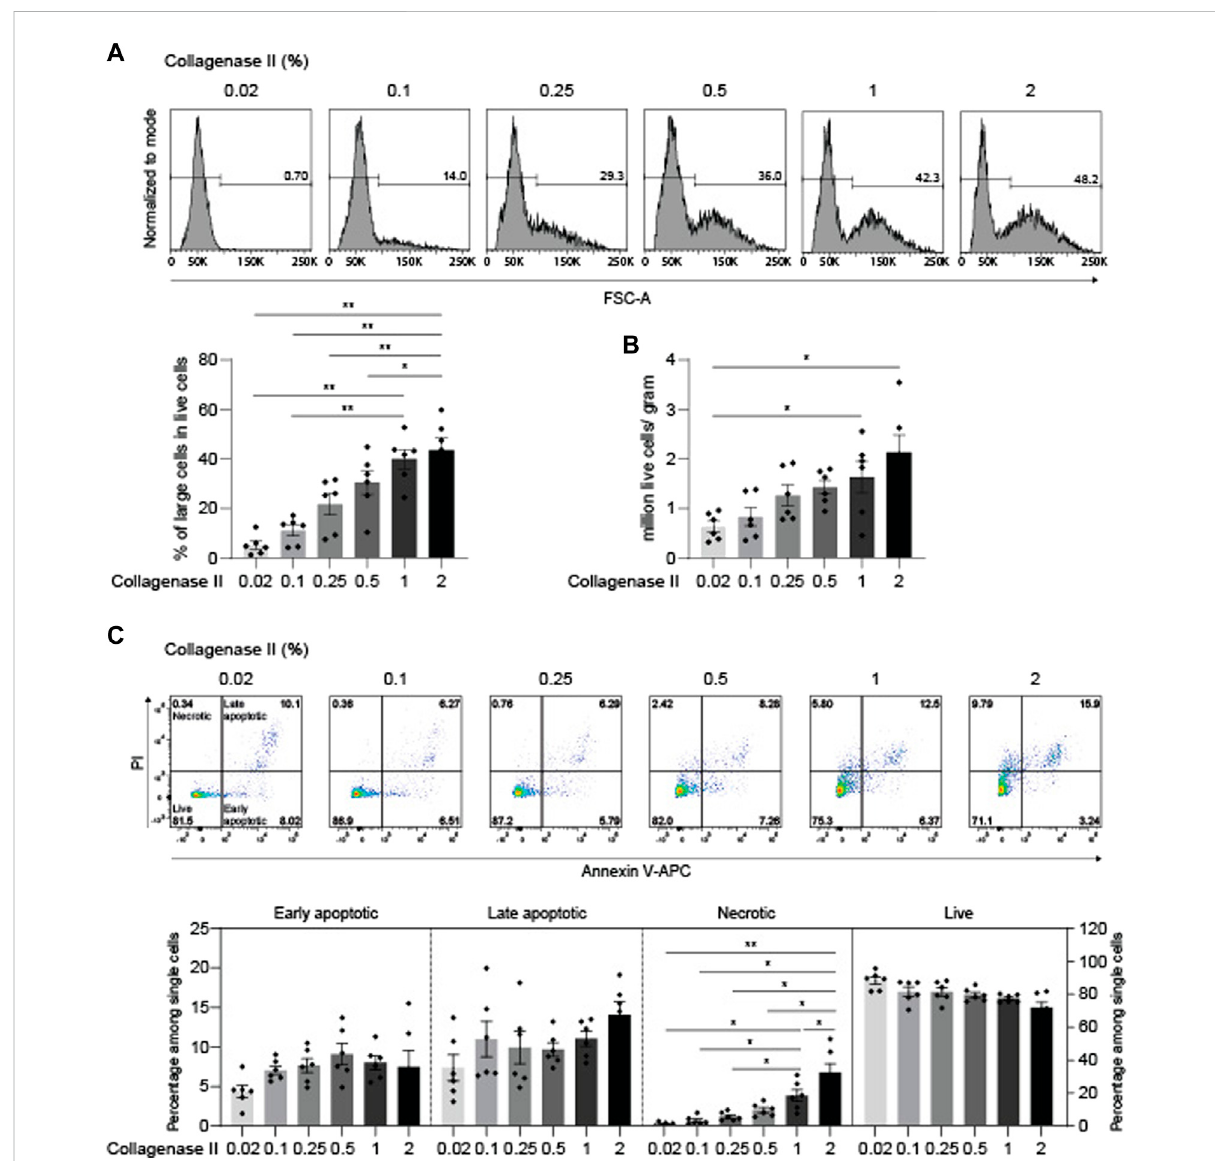
FIGURE 6 Down-titration of collagenase II yields optimized chondrocyte recovery including large cells at high viability. After being fi nely minced, human articular cartilage tissue was divided equally into six portions, and the samples were digested for 4 h with 0.02%, 0.1%, 0.25%, 0.5%, 1%, and